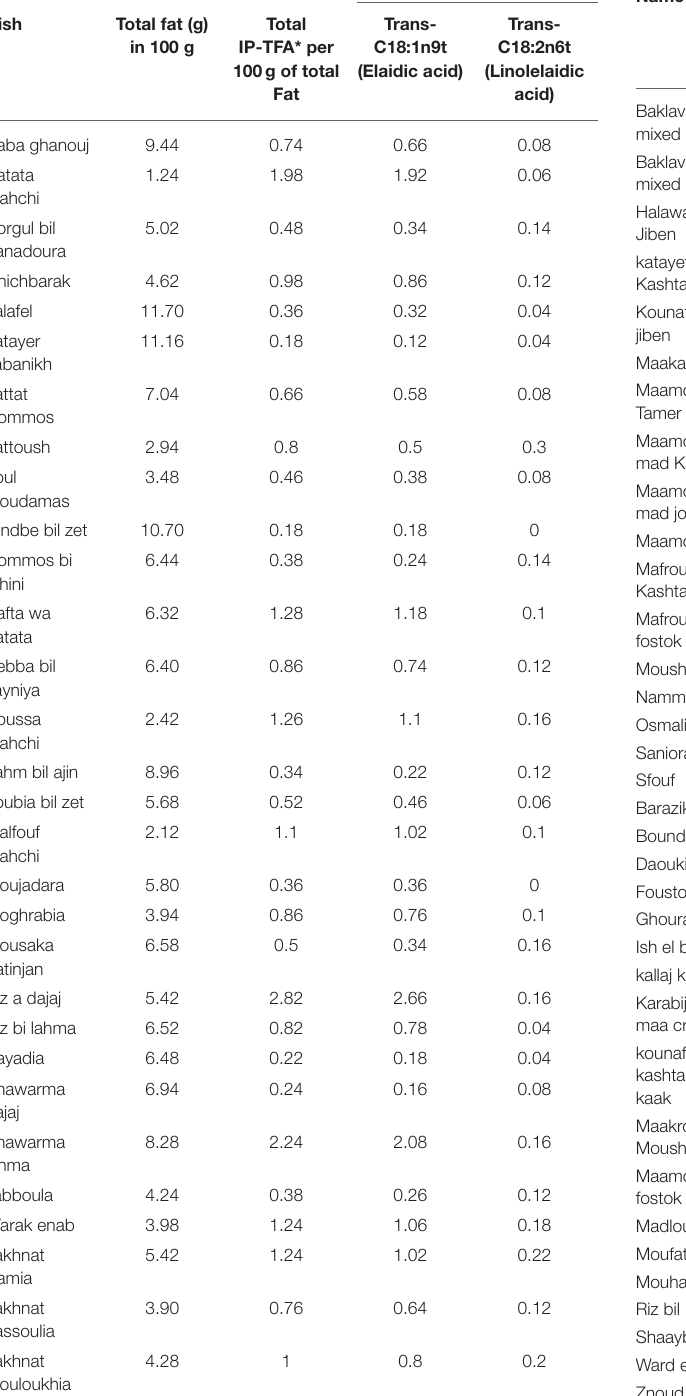
TABLE 2 | Mean levels of total fat in 100g of edible portions, total IP-TFAs, and IP-TFAs (EA and LEA) in 100g of total fat of frequently consumed Arabic